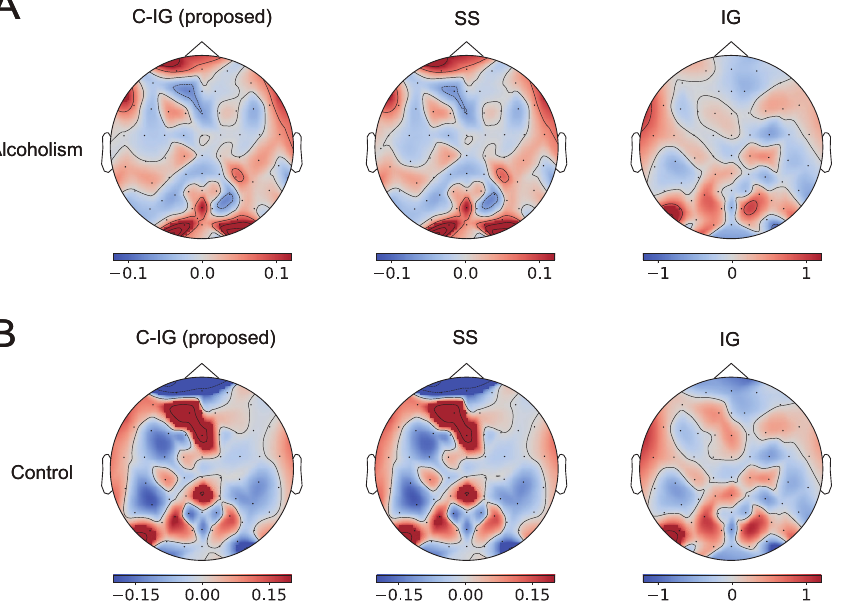
Figure 3. Contributions of EEG electrodes over the scalp to classify alcoholism ( A ) and control ( B ) using the temporal CNNs. The average contributions of the methods applied to 100 data examples from the UCI EEG dataset are shown. The red and blue areas represent positive and negative contri- butions to the classifications, respectively. The proposed method involves the compensated integrated gradients (left panels), the Shapley sampling shows the desired contributions as a reference (middle panels), and integrated gradients show the contributions obtained using the original integrated gradients method with the zero-input baseline (right